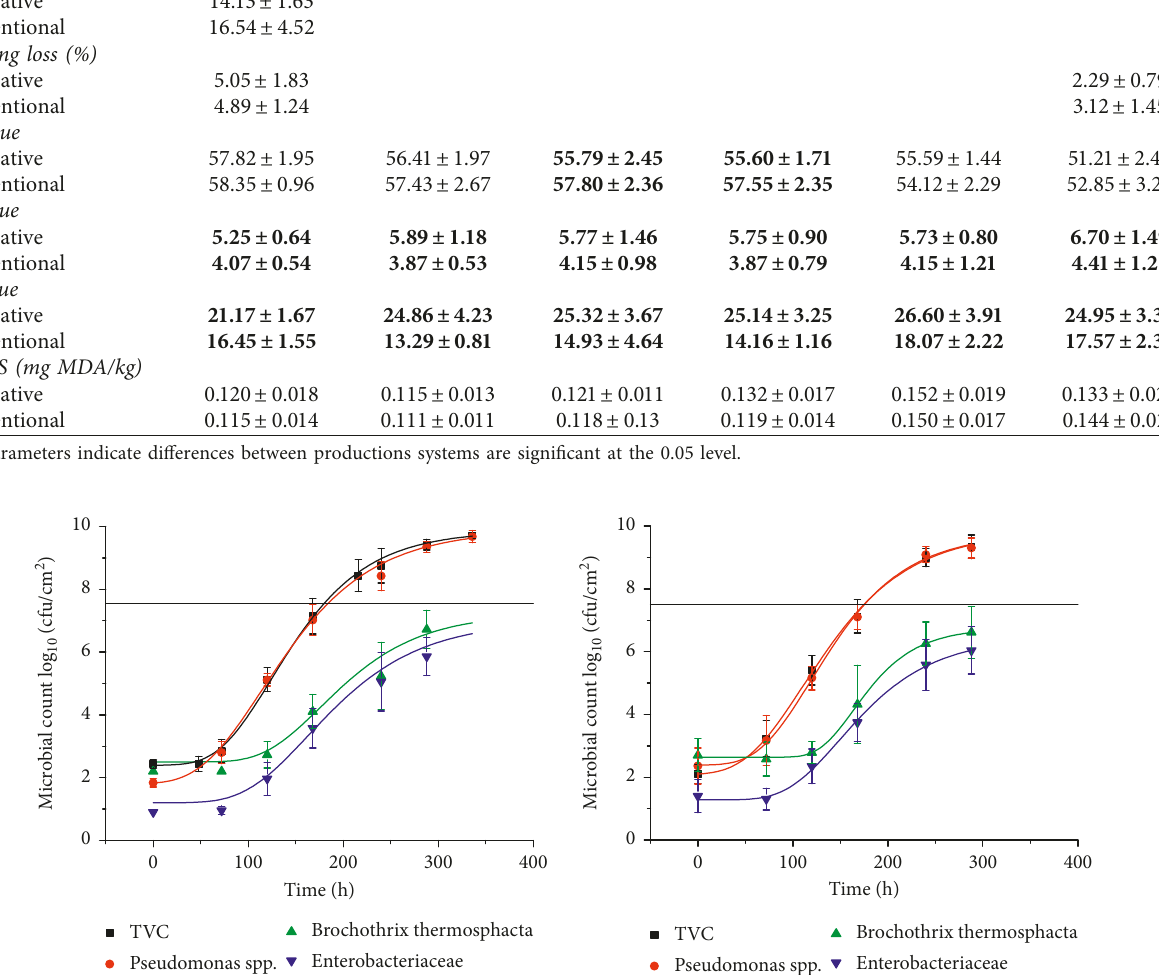
Figure 2: Evolution of microbiological contamination on filets of the alternative (a) and conventional (b) production